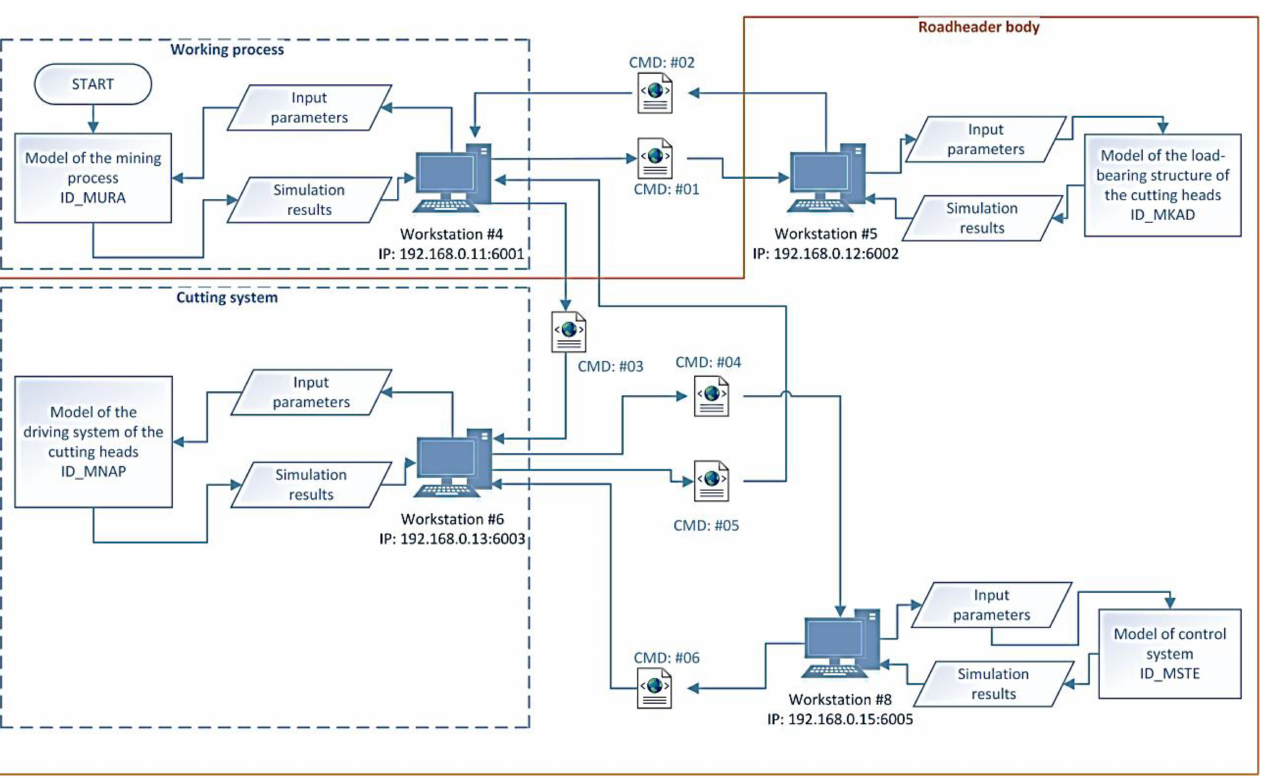
Figure 8. Block diagram of the Computer Simulation Module and the method of data exchange between